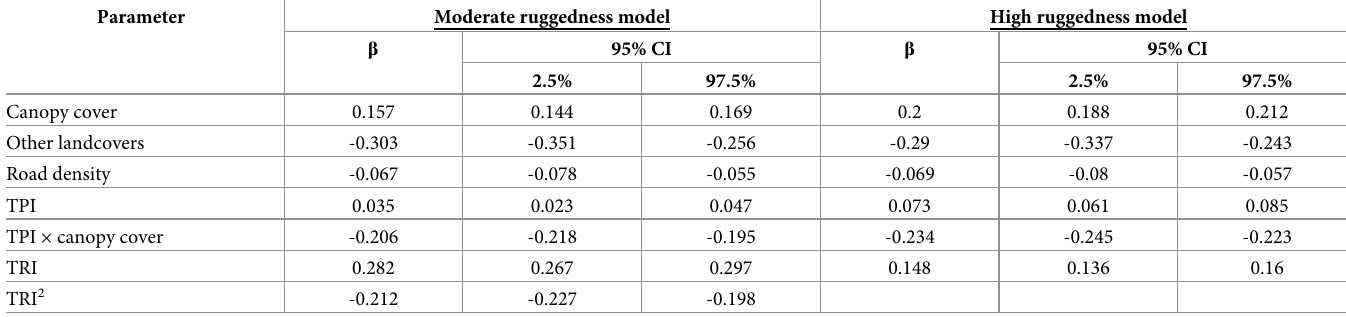
cumvent predation risk from wolves in western Montana. Table 3. Resource selection coefficients and confidence intervals (CIs) from top-ranked fixed effects resource selection functions for mountain lions. Parameter